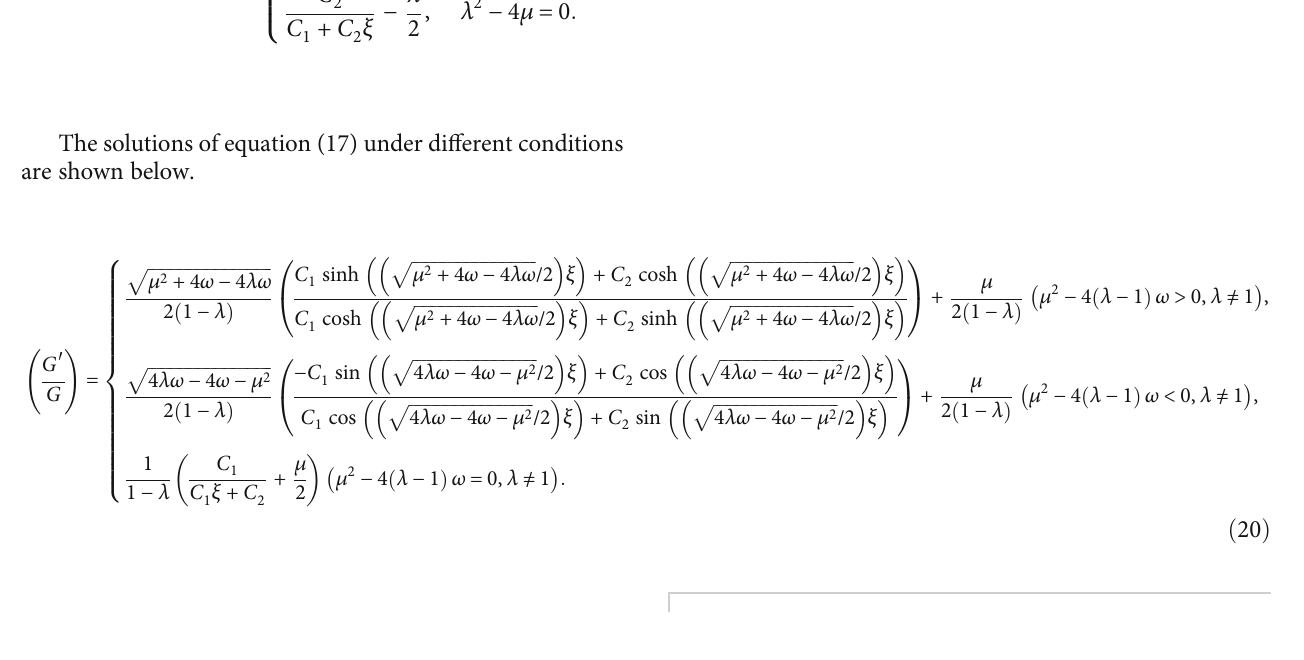
ffiffiffiffiffiffiffiffiffiffiffiffiffiffiffi p ffiffiffiffiffiffiffiffiffiffiffiffiffiffiffi λ 2 − 4 μ ffiffiffiffiffiffiffiffiffiffiffiffiffiffiffi p ffiffiffiffiffiffiffiffiffiffiffiffiffiffiffi 4 μ − λ 2